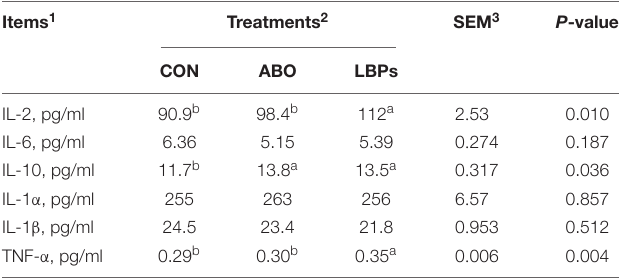
FIGURE 1 | Diarrhea rate of weaned piglets fed MB dietary treatments (%) ( n = 8). CON, basal diet; LBPs, basal diet + 4,000 mg/kg LBPs; ABO, basal diet + 20 mg/kg flavomycin + 50 mg/kg quinocetone. Asterisks express statistical differences between different groups: * P < 0.05.